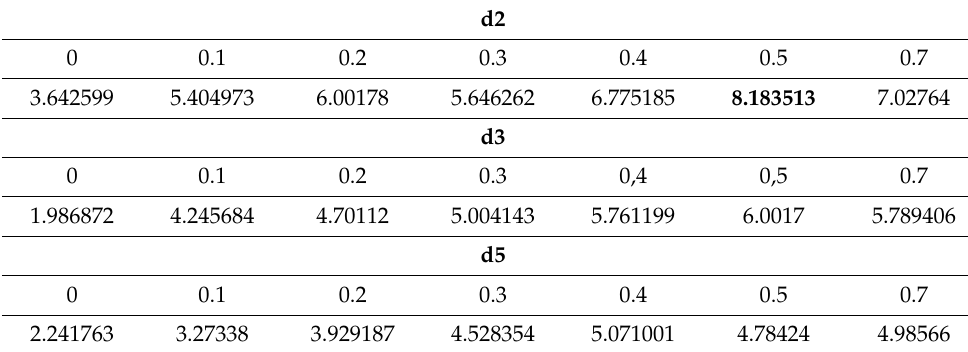
Table 7. Ranking of alternatives for w/c = 0.5.